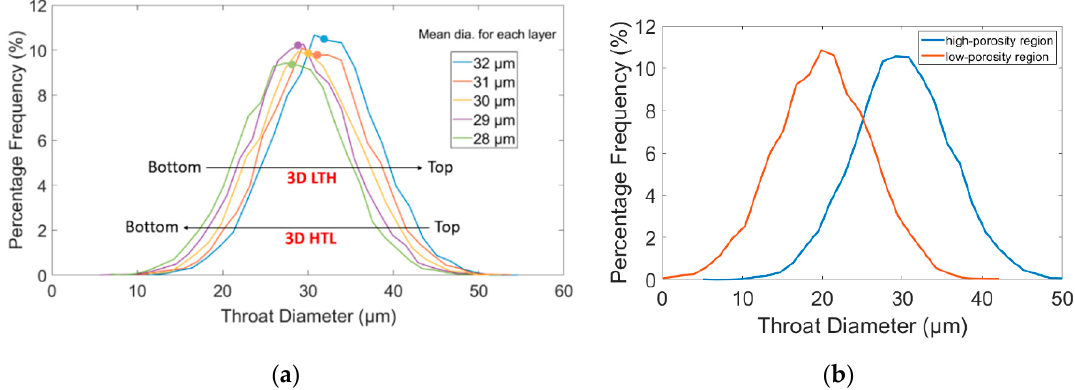
Figure 4. Visualization of the layered pore size distributions investigated in this study: ( a ) 3D low-to-high (LTH) and high-to-low gradients (HTL); ( b ) 3D dual-porosity network (only the curves of the two regions are shown). Note that a pore network slice is comprised of one horizontal layer of throats (in vertical and horizontal direction) and one pore layer. For this reason, the data points of only 5 slices are shown in ( a ) for the 3D pore network.